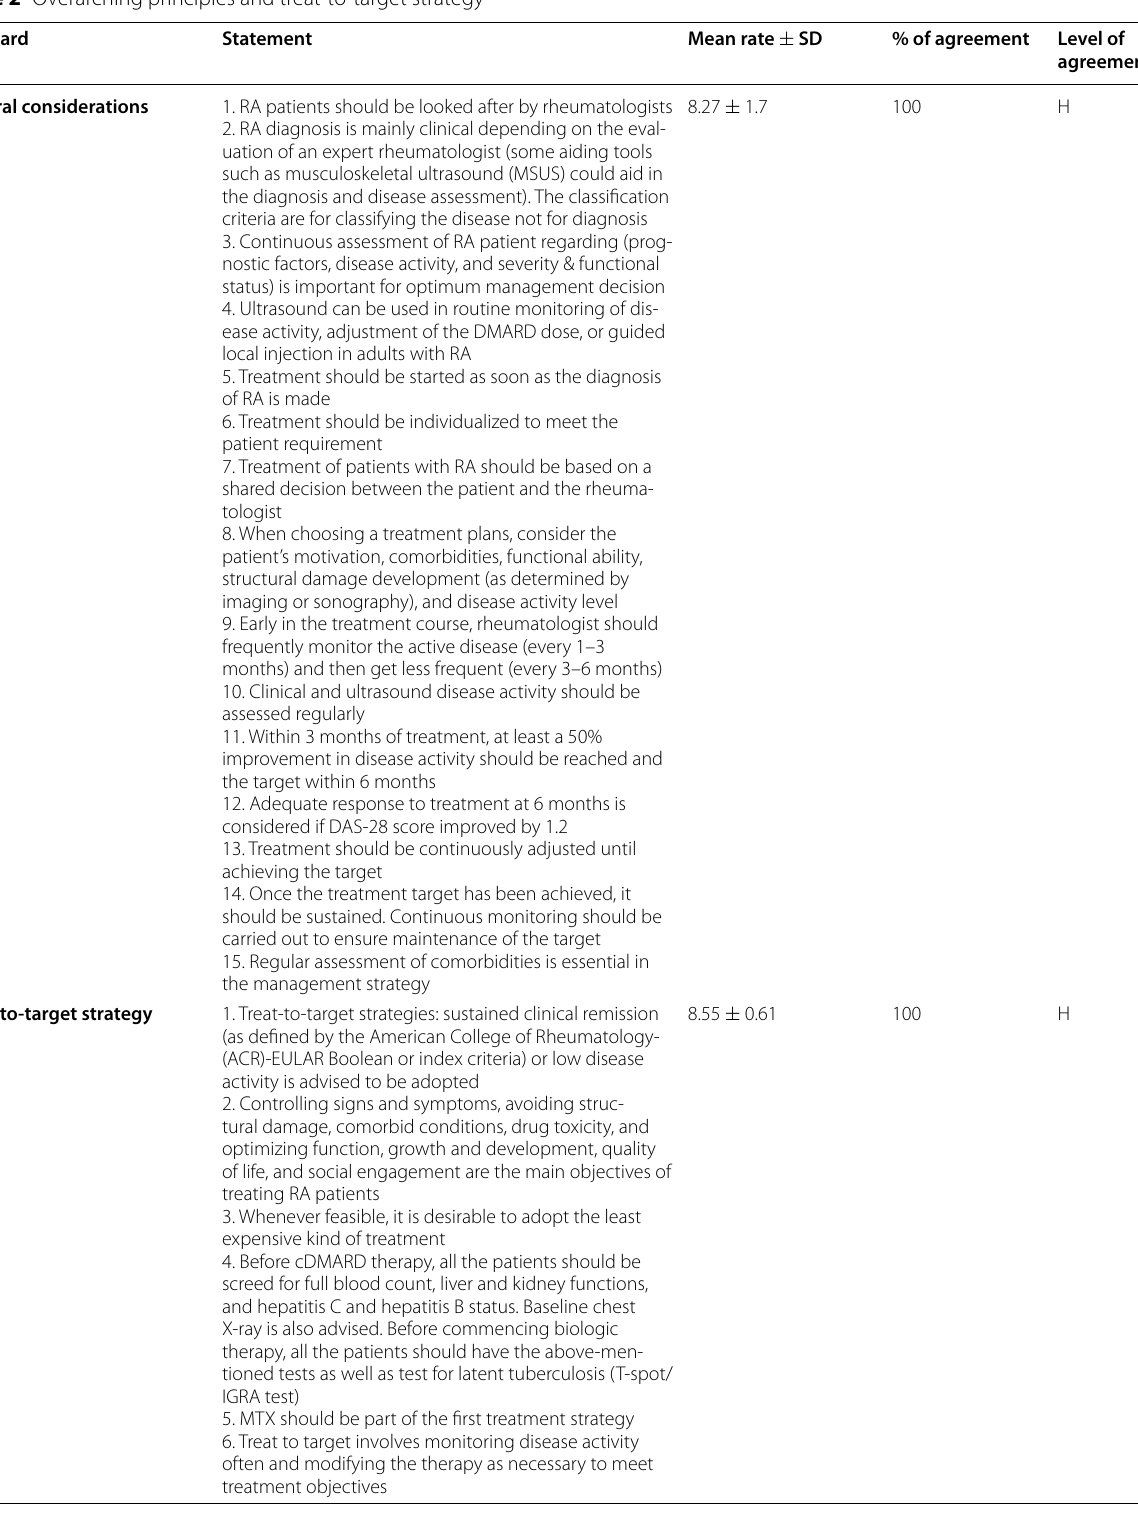
Table 2 Overarching principles and treat‑to‑target strategy Standard General